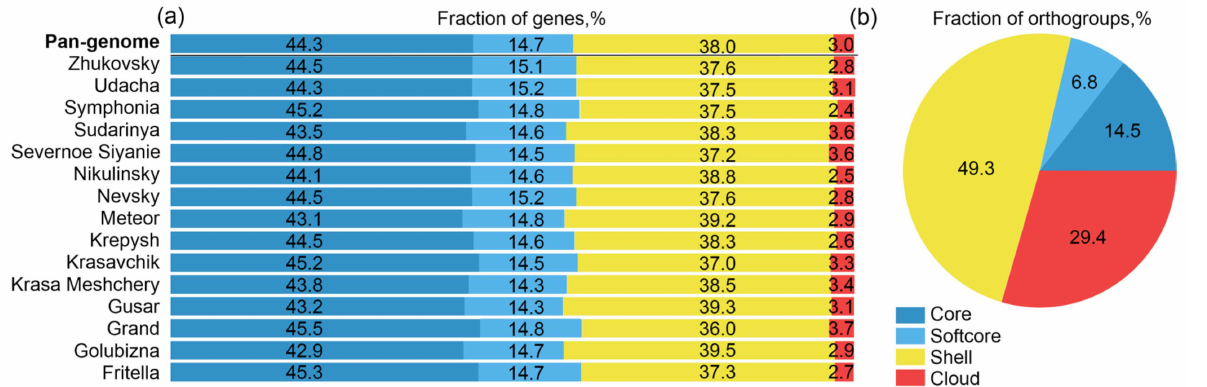
Figure 1. Summary assessments for the proportion of genes ( a ) and orthogroups ( a ) present in pan-genome of 15 assemblies of Russian potato cultivars. ( a ) Bar chart for the proportion of core, softcore, shell, and cloud genes in the pan-genome (top bar) and each cultivar. X -axis: the fraction of genes. Y -axis: cultivars denoted by abbreviations. ( b ) Pie chart for the distribution of core, softcore, shell, and cloud orthogroups in the pan-genome. Color legend for pan-genome parts is shown below the pie